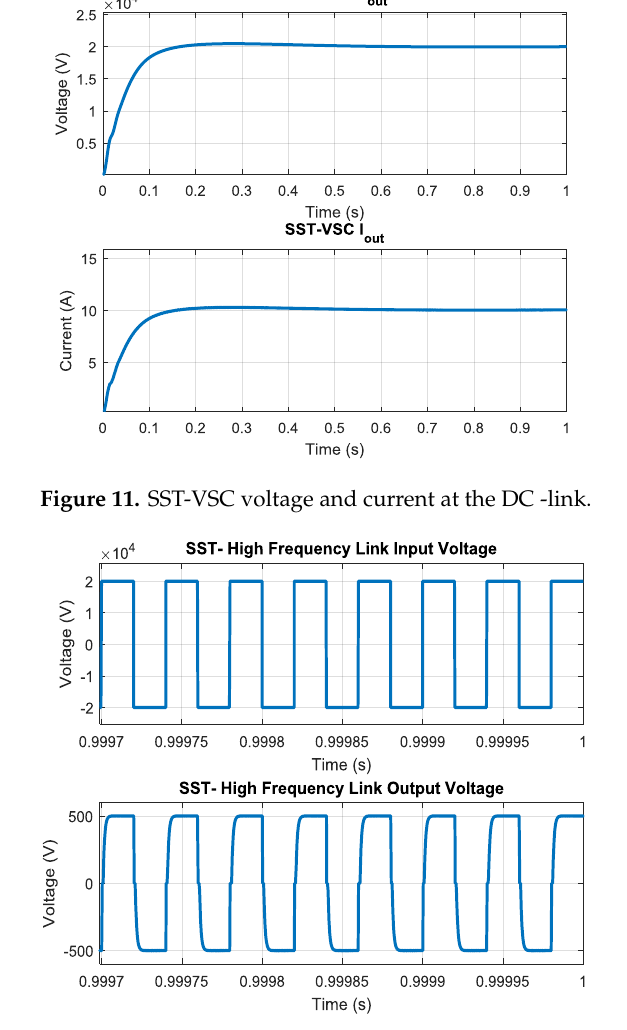
Figure 12. Primary and secondary voltage of the high frequency transformer.